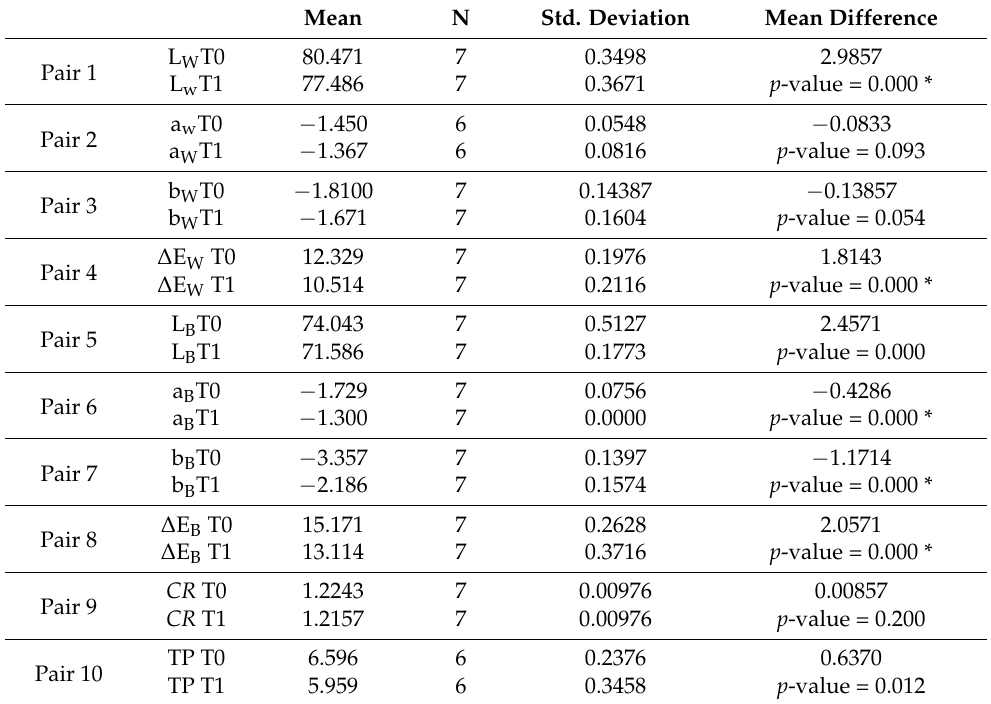
Table 6. Paired sample statistics (1450 °C).